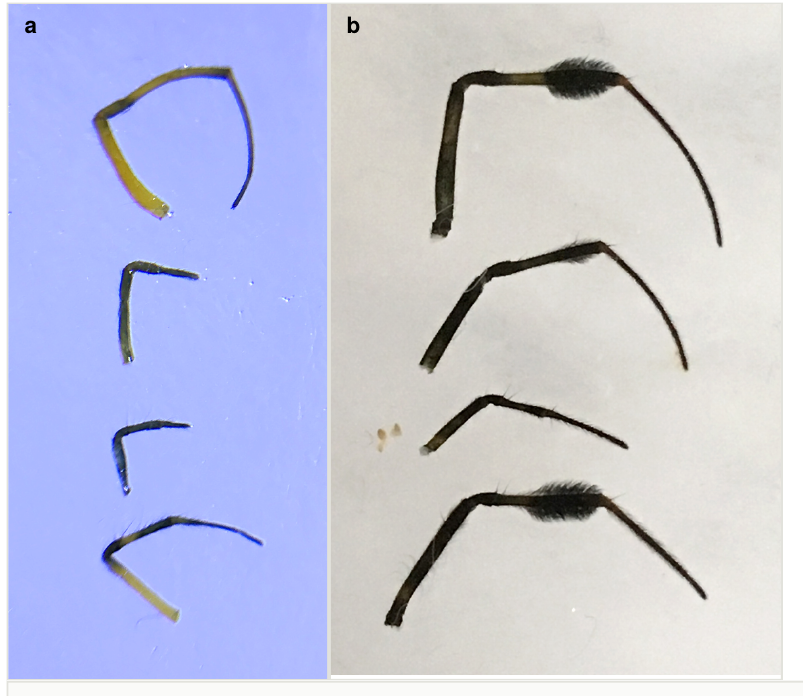
Figure 4. Opadometa sarawakensis Dzulhelmi & Suriyanti, 2015, left legs, prolateral view. a : Left legs of male (DGFCW2018022300), arranged top to bottom I-II-III-IV. Leg II broken, missing metatarsus and tarsus. b : Left legs of female (DGFCW2018022402), arranged top to bottom I-II-III-IV. Note large tufts of setae on distal part of tibiae I and IV, and more diminutive tuft on tibia Abdomen gray dorsally with silvery patches and an anteriodorsal dark spot, black posteriorly and ventrally with two posteriolateral and one ventral orange spot, with a small anteriolateral black spot and a larger posteriolateral black spot, which joins with the black ventral marking.